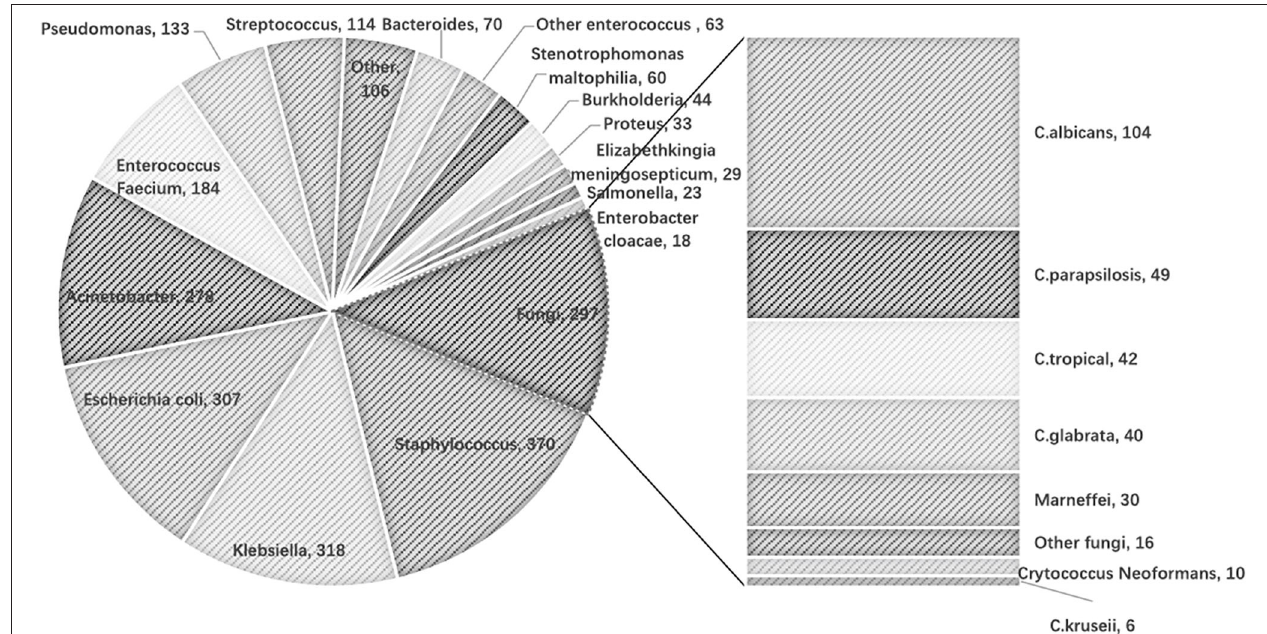
FIGURE 2 | Distribution of the microbiological isolates in study cohort.